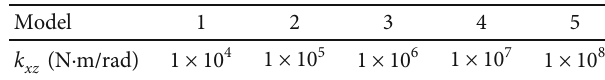
ω ω − ω ω + ω 1 ; (b) 2 ; (c) 1 2 ; (d) 1 2 .